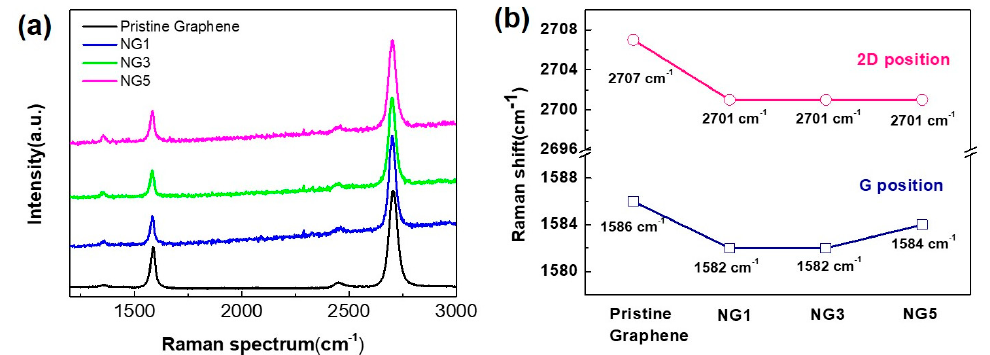
Figure 4. Raman spectra for pristine graphene and N-doped graphene. ( a ) Raman spectrum and ( b ) G and 2D band positions (derived from the Raman spectra).